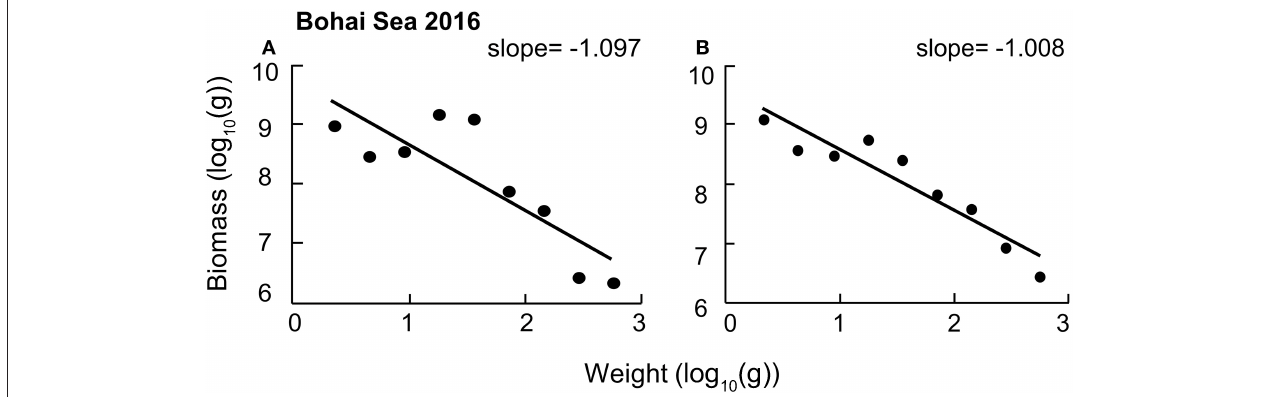
FIGURE 2 | Results of particle size distribution (PSD) for the model of Bohai Sea (2016) in China. (A) Before adjusting the biomass of jellyfish. (B) After adjusting the biomass of jellyfish.